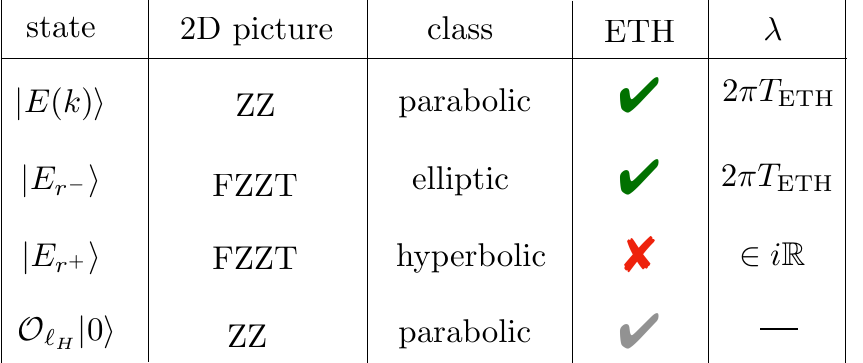
E denote the r (cid:6) i j